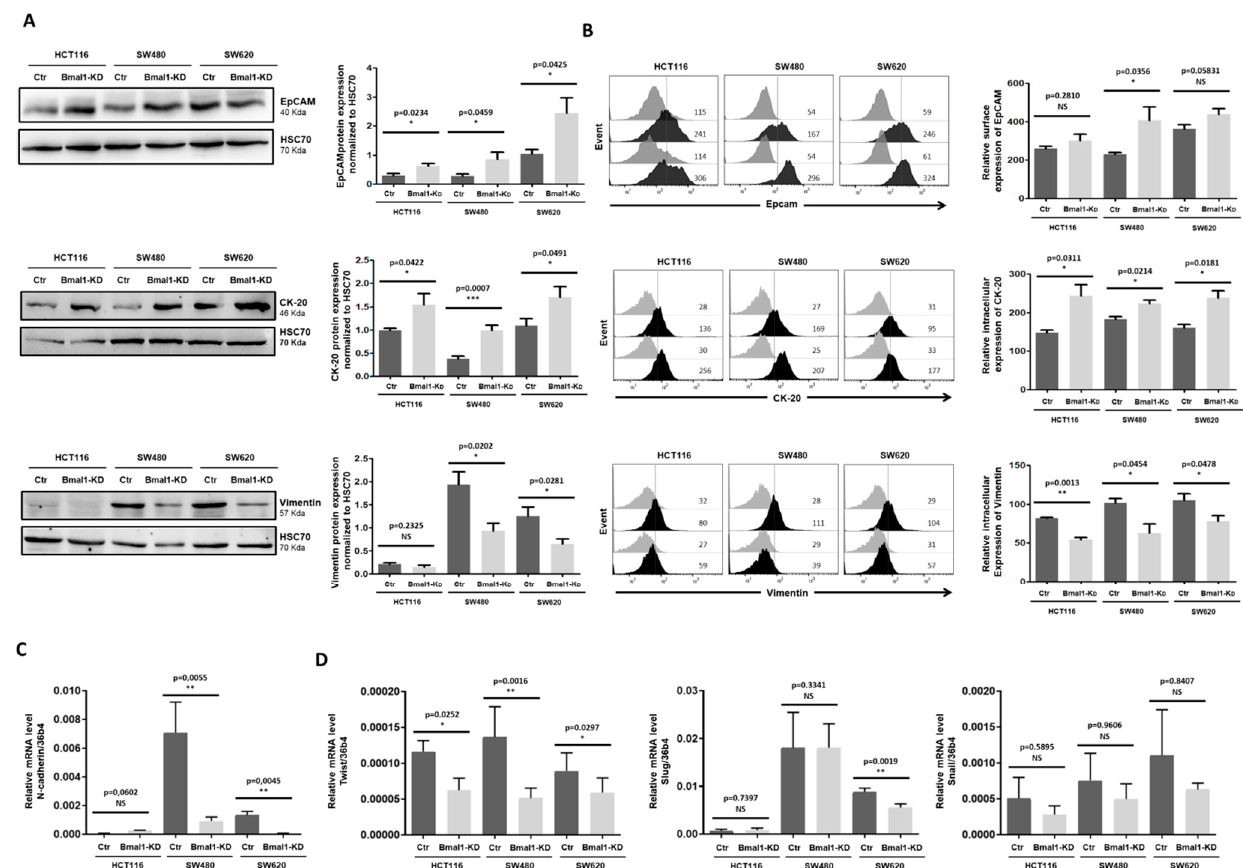
Figure 3. BMAL1-KD leans epithelial–mesenchymal balance of CRC cells toward epithelial properties. ( A ) Western blot revealed that BMAL1-KD increased the expression of the epithelial markers EpCAM and cytokeratin-20 (CK-20) and decreased the mesenchymal marker (vimentin) in BMAL1-KD CRC cell lines. HSC70 was used as loading controls. ( B ) EpCAM surface expression and intracellular expression of vimentin and CK-20 were analyzed by flow cytometry. Left, Representative stainings of one experiment are shown. Staining of the cells with the antigen-specific antibody is represented by the dark-colored histograms and staining with the isotype-matched control antibody correspond to the gray histograms. At the right of each histogram are shown the mean fluorescence intensity values for each staining. Right, Graphs represent the relative expression of EpCAM, CK-20, and vimentin in three independent experiments (* p < 0.05, ** p < 0.01, *** p < 0.001). ( C ) Quantitative RT-PCR revealed that RNA expression level of mesenchymal hallmarker N-cadherin was significantly decreased in SW480 BMAL1-KD and SW620 BMAL1-KD cell lines. The BMAL1-KD HCT116 cell line exhibited a decreased tendency of N-cadherin ( p = 0.0762) ( n = 5, ** p < 0.01). Data are shown as means ± SEM. ( D ) Quantitative RT-PCR analyzed the RNA expression level of three EMT-activating transcription factors Twist, Slug, and Snail in control and BMAL1-KD CRC cell lines. BMAL1-KD decreased significantly the expression of Twist but not Slug and Snail ( n = 5, * p < 0.05, ** p < 0.01). Data are shown as means ±